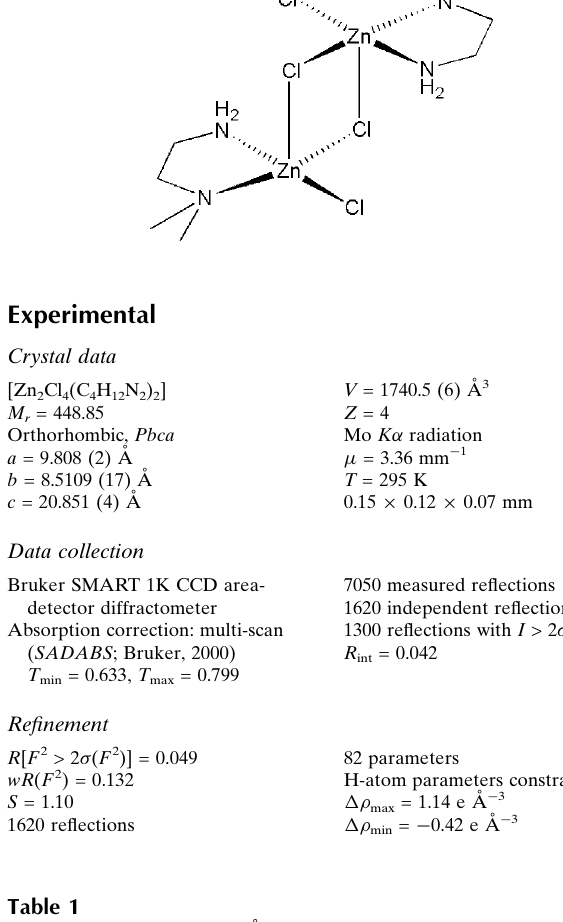
Hydrogen-bond geometry (A˚ , (cid:5)